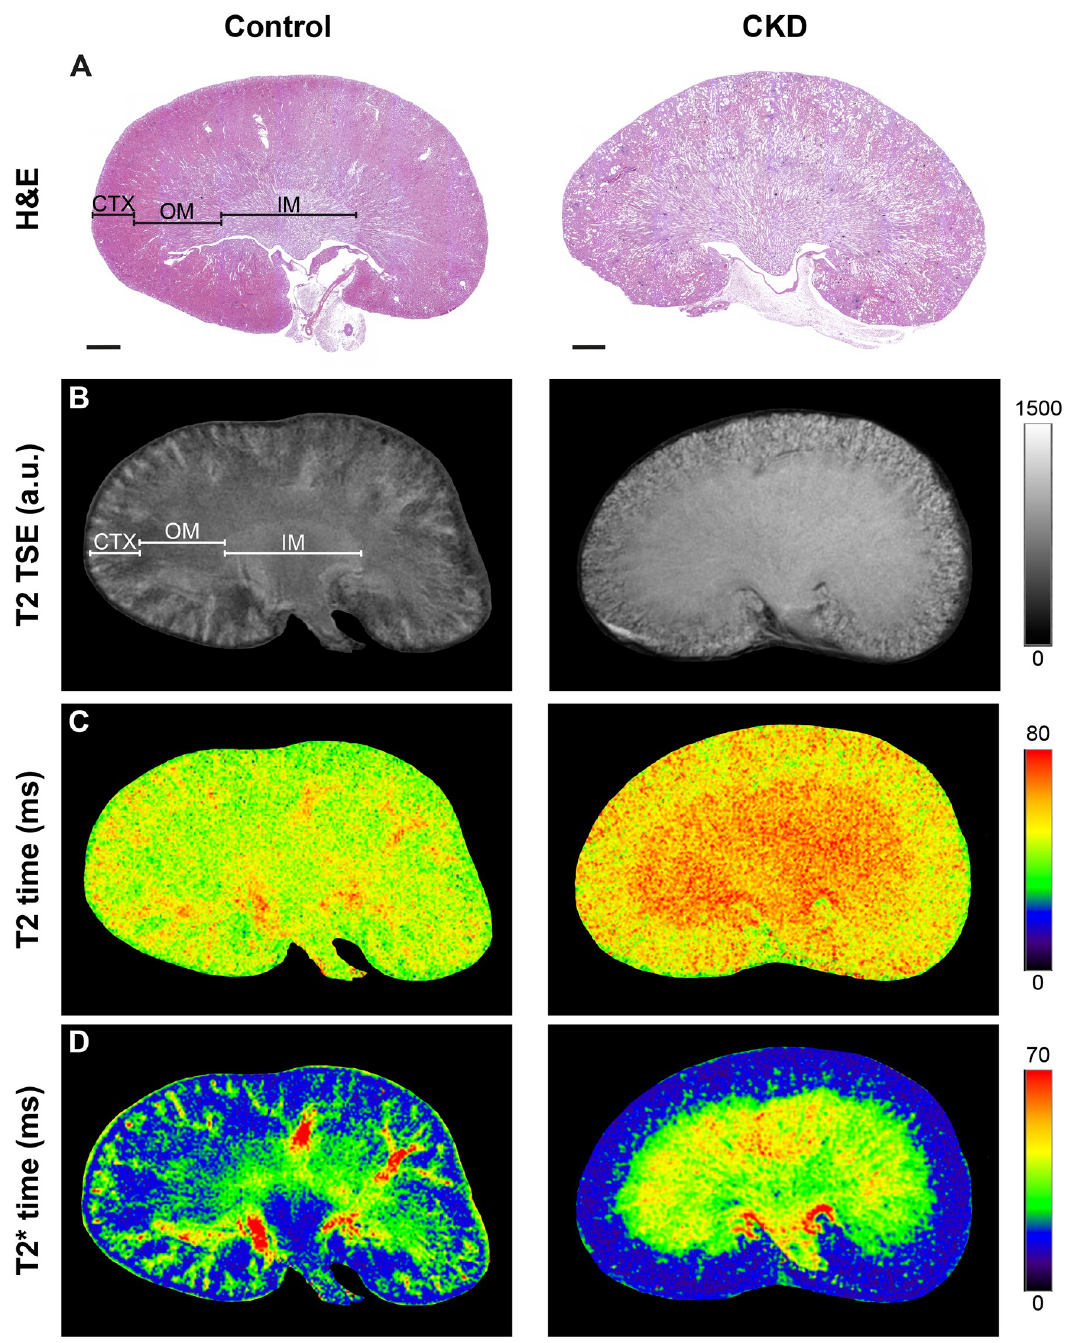
Fig 2. Comparison of histology, morphological and functional MRI. Representative hematoxylin & eosin (H&E) stained kidney sections (A), T2 weighted turbo spin echo (TSE) MR images (B), T2 relaxation time maps (C) and T2 � relaxation time maps (D) of control (left) and CKD mice (right). Renal regions are indicated as CTX, cortex, OM, outer medulla, and IM, inner medulla. Scale bars, 1 mm.